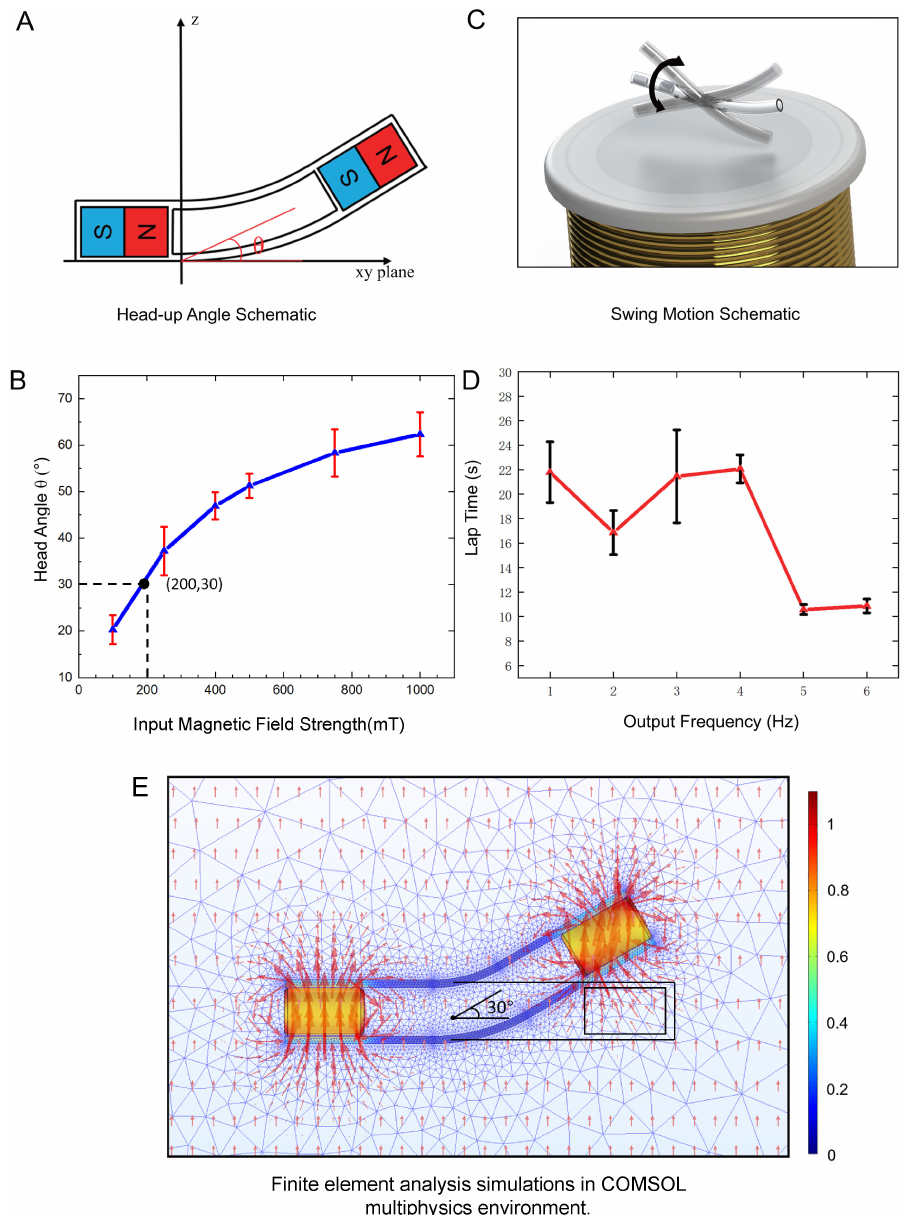
Figure 5. Head-up test and swing motion results. ( A ) The head-up angle of the MHCMM itself can be obtained by changing the input signal to the electromagnetic coil amplifier. ( B ) Experimental results of six sets of head-up angles versus input magnetic field strength. ( C ) A 3D schematic of oscillating forward motion with an electromagnetic coil underneath, which produces an oscillating magnetic field. ( D ) The electromagnetic coil, which has an output magnetic field strength of 300 mt, is controlled to produce an oscillating magnetic field of different frequencies, and the lap time is the time taken to make one revolution along a 35 mm diameter Petri dish. ( E ) The deformation of MHCMM under the action of an external magnetic field of strength 210 mT. The analysis result is consistent with the test